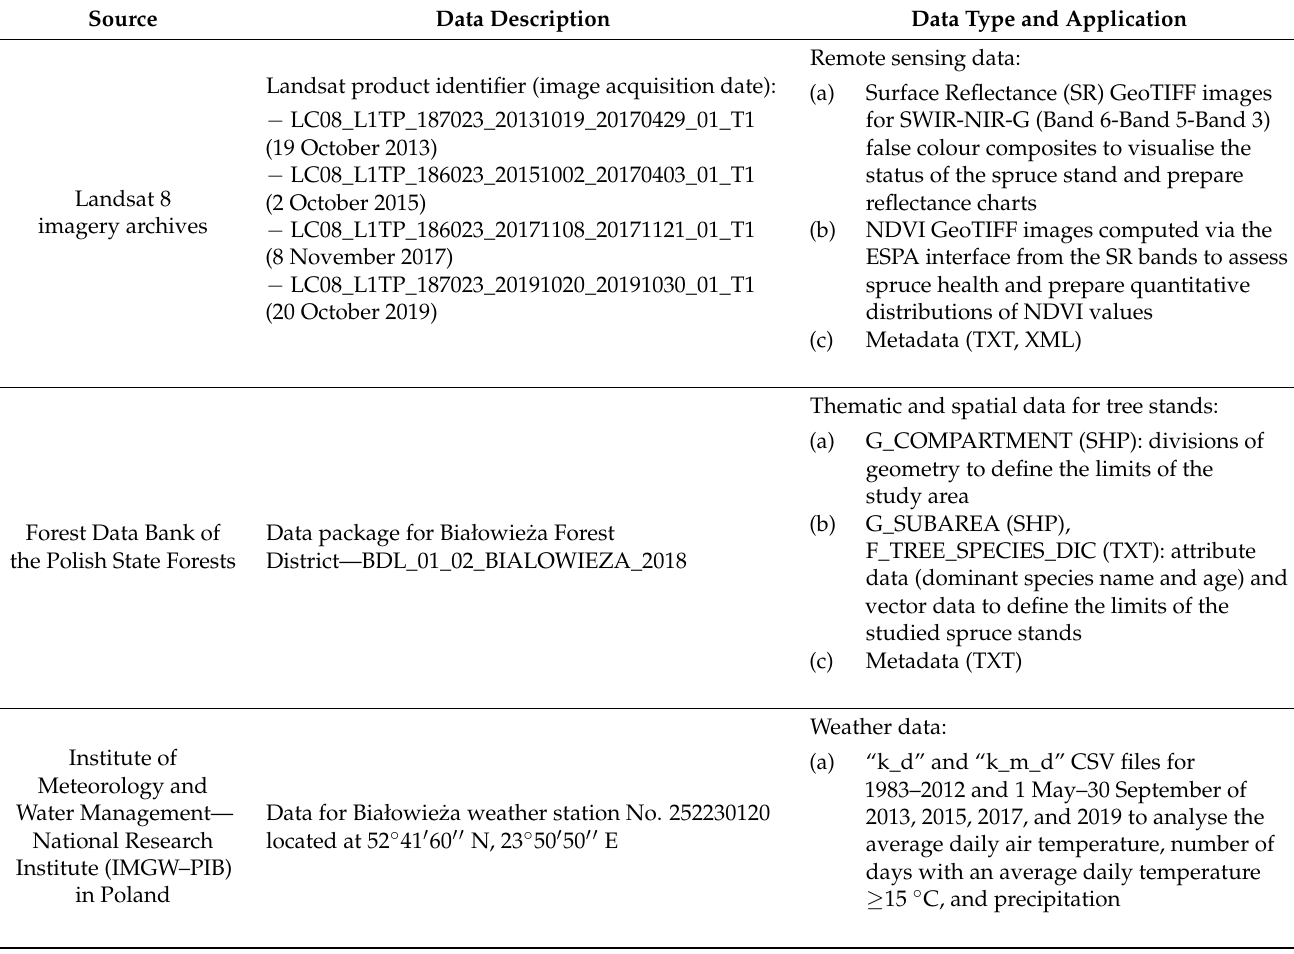
Table 1. Description of the data applied in the analysis of the studied spruce